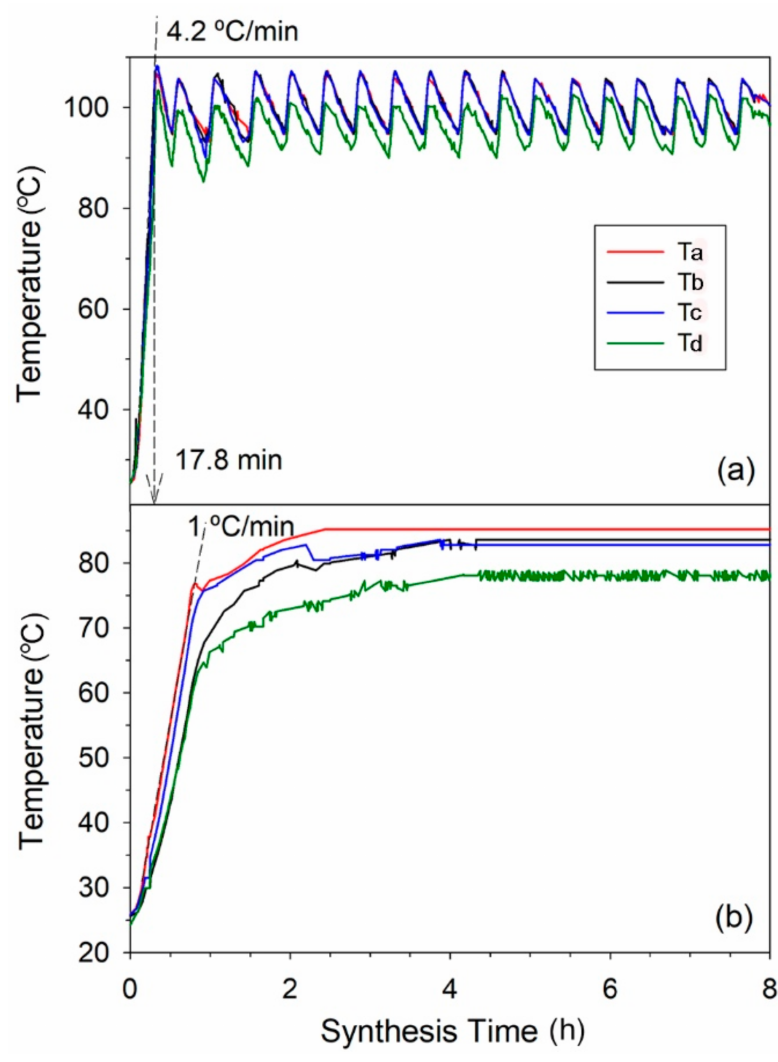
Figure 2. The temperature profiles of the reaction mixture of NaX zeolite for non-stirred synthesis by: